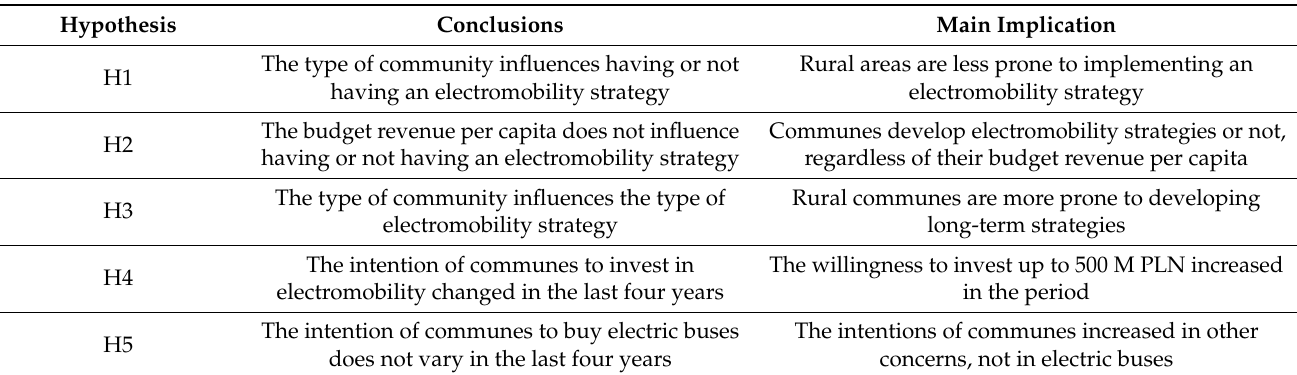
Table 6. Synthesis of the conclusions of the